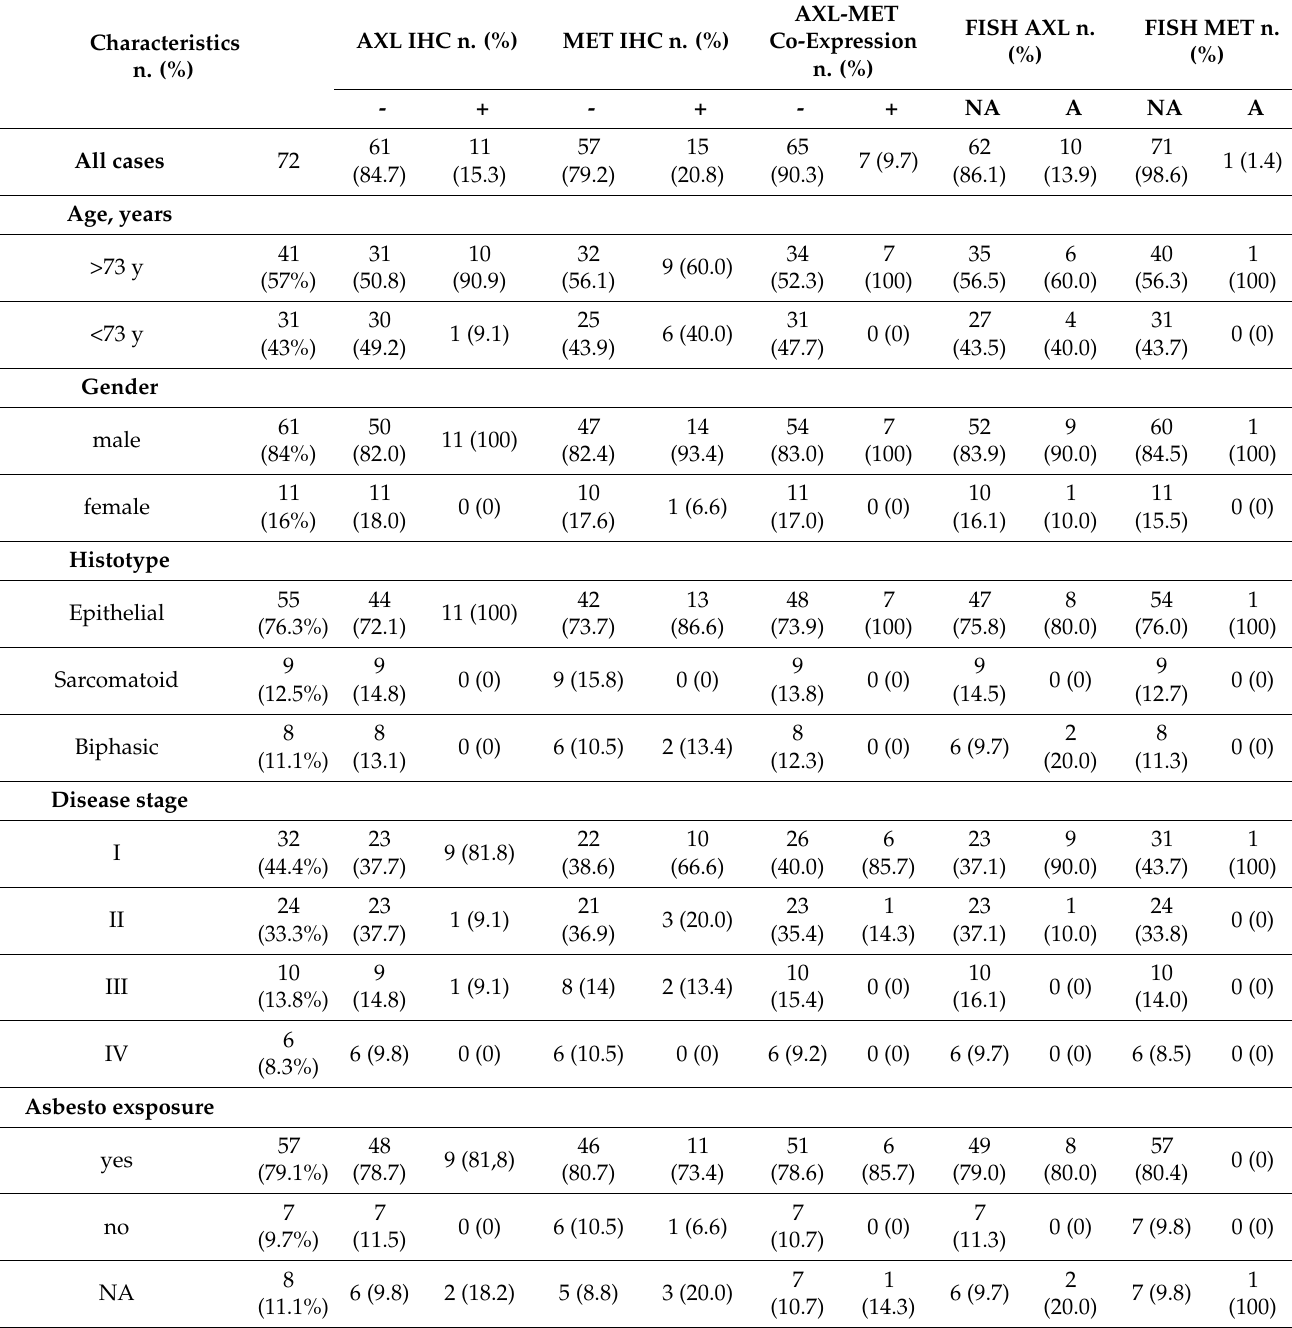
Table 2. IHC and FISH results of AXL/MET and the clinical-pathological features of the series